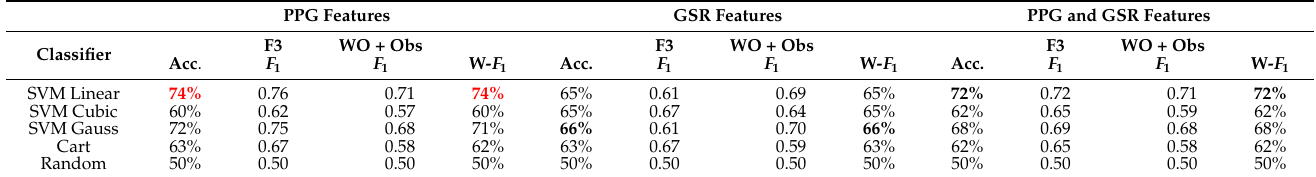
Table 10. Performance of the binary classifiers in discriminating tasks having similar walking pace considering the signals collected from young adults. Two tasks have been compared: the metronome forced speed task of 100 bpm F3 and the collision avoidance task WO+Obs, including, in a single instance, both the free walking before and after the collision avoidance zone and the obstacle crossing. The analysis are performed varying the feature set used (PPG, GSR or PPG and GSR) and adopting a LOSO validation strategy. Three performance metrics are reported: accuracy (Acc.), F1-score ( F 1 ) and weighted F1-score (W- F 1 ). The W- F 1 values in bold represent the best performances achieved for each feature set considered, while in red is highlighted the best accuracy at